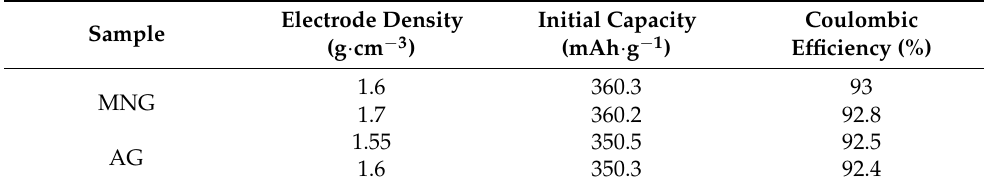
Table 2. Initial capacities and coulombic efficiencies of MNG and AG samples with different electrode densities.